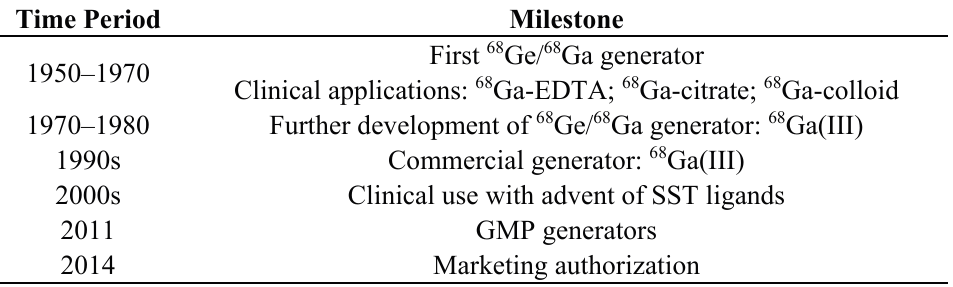
Table 3. Milestones of 68 Ge/ 68 Ga generator